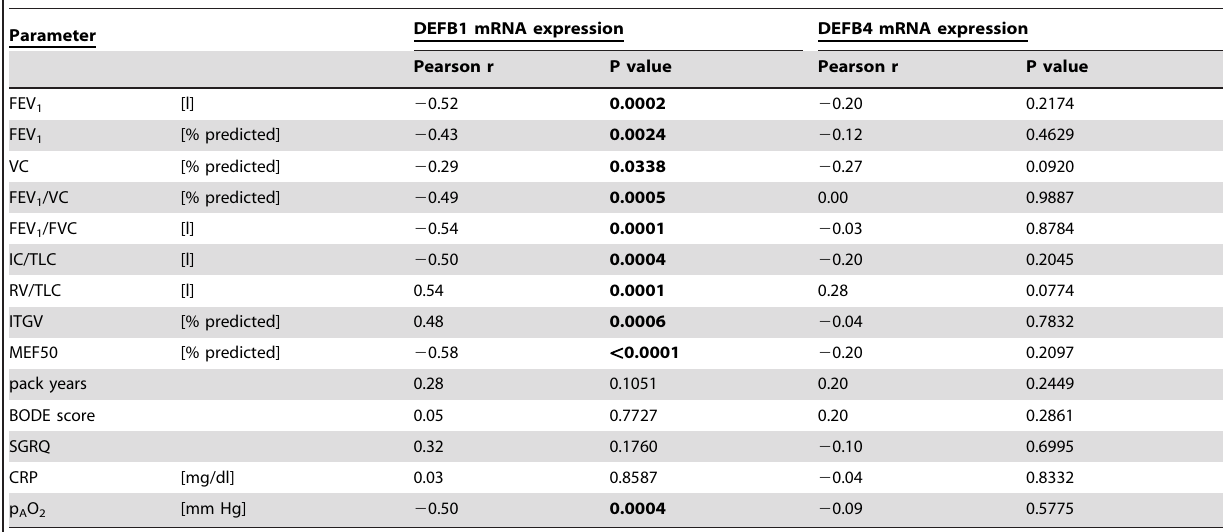
Table 2. Correlation analysis of DEFB1 and DEFB4 mRNA expression.